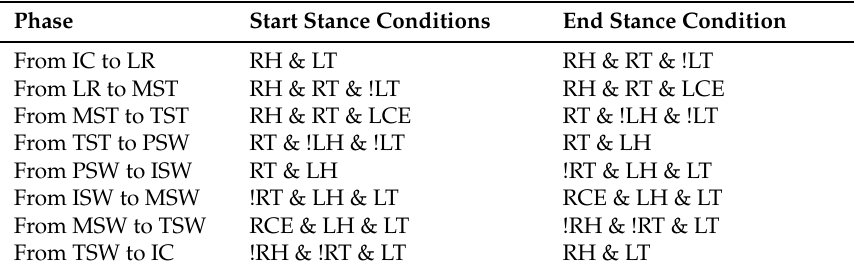
Details of the segment phases and how locomotion sequences were